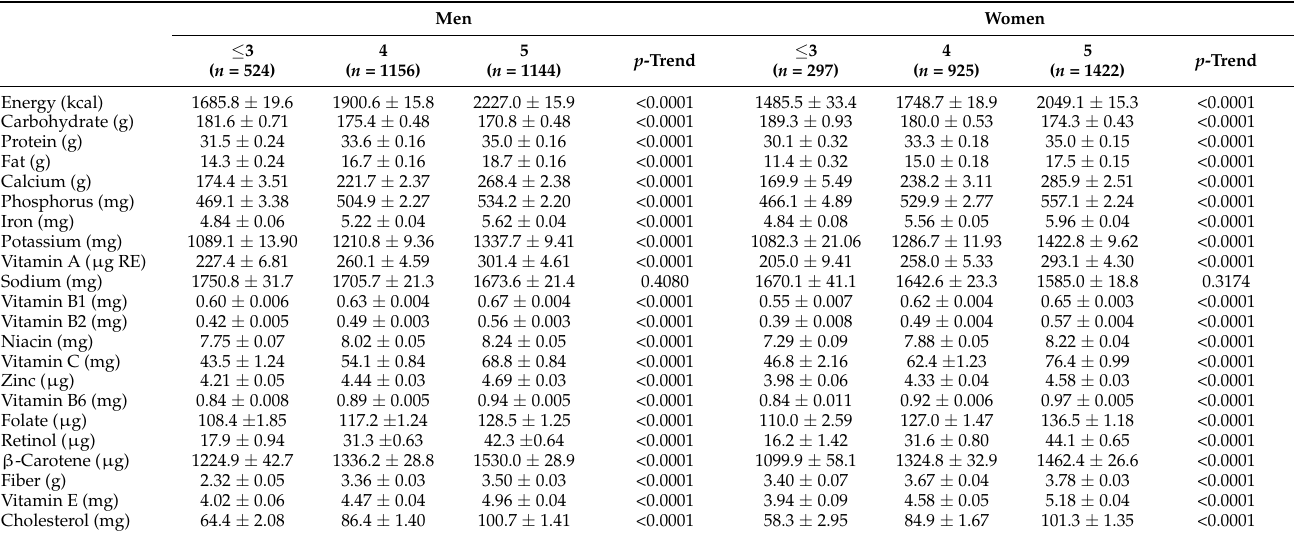
Table 3. Nutrient intake according to dietary diversity